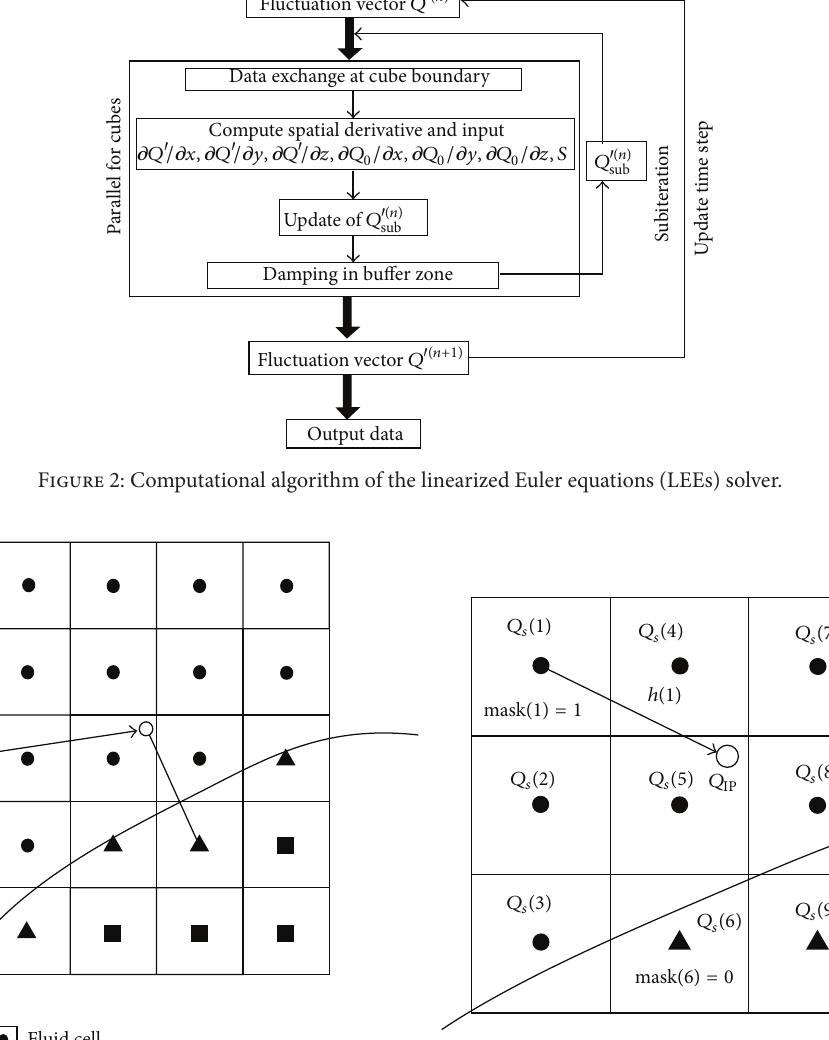
normal vector of the wall surface; and V IP , 𝑝 the velocity vector, pressure, and density at the IP and V GC ,